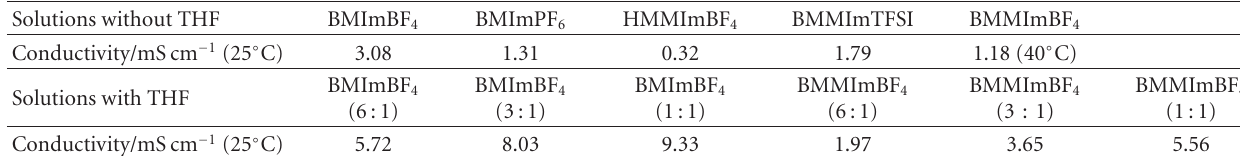
Table 2: Conductivity of the solutions dissolving 0.3molL − 1 Mg(CF 3 SO 3 ) 2 in ILs without or with THF by di ff erent volume ratios for ILs and THF.